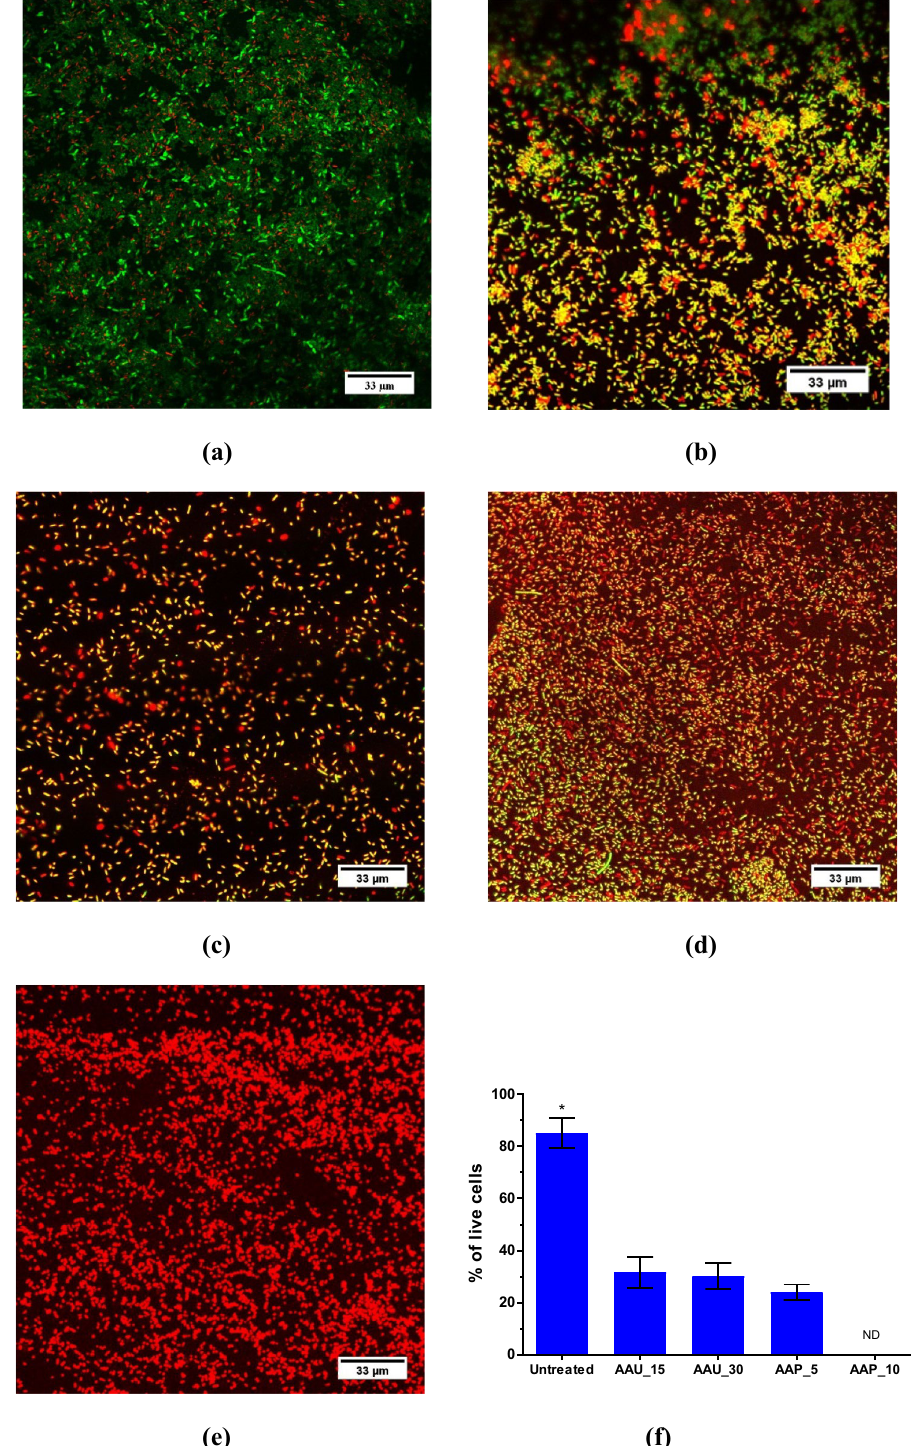
Figure 5. ( a – e ) Confocal laser scanning microscopy images of E. coli 96 h biofilm stained with Live/Dead stain ( a ) untreated control; ( b ) 15 min AAU treatment; ( c ) 30 min AAU treatment; ( d ) 5 min AAP treatment; ( e ) 10 min AAP treatment. Scale bars = 33 μm. SYTO 9 (green cells) denotes live viable cells, whereas the propidium iodide (red/yellow cells) indicates dead cells that have been deactivated because of ruptured or damaged membranes; ( f ) percentage of live viable cells after AAU and AAP treatments (n = 6). The asterisk indicates significance difference between different treatments (p ≤ 0.05) analysed by one-way ANOVA and Tukey multiple comparison post hoc test. Graph was generated using GraphPad Prism version 5.0 (GraphPad Software, San Diego, California USA, http://www.graph